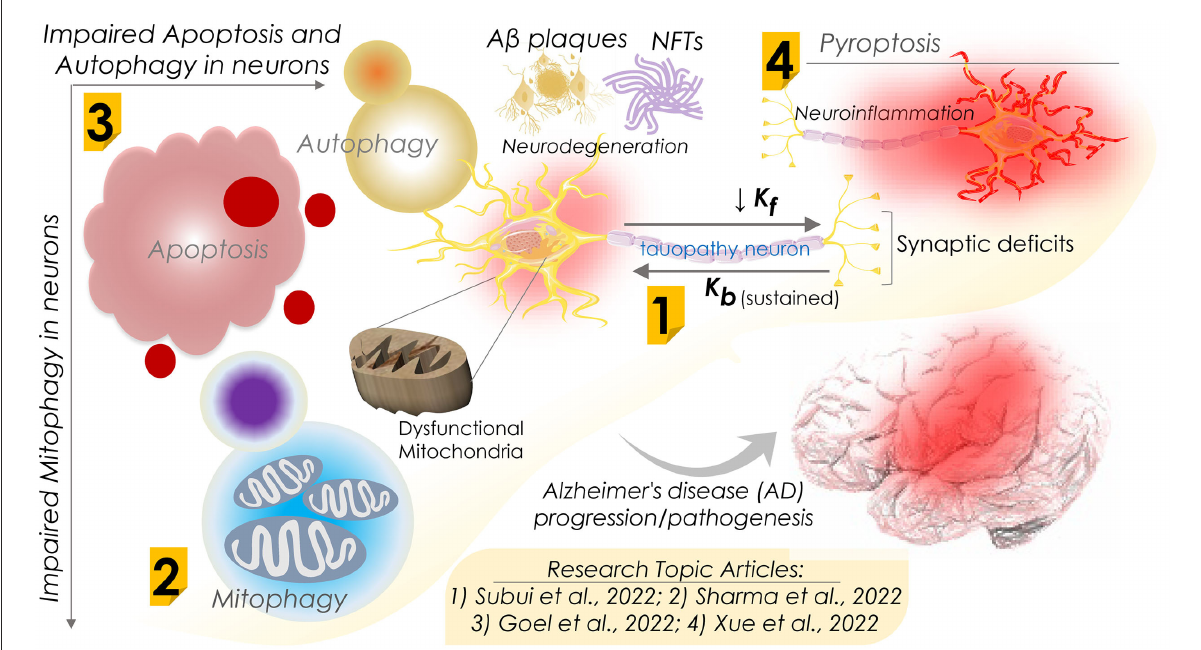
FIGURE1 Schematic diagram showing dysfunctions of apoptosis, autophagy, mitophagy, and pyroptosis in Alzheimer’s disease progression and their mechanisms. Research Topic articles are denoted by serial number within the related schematic section; k f and k b represent kinesin and dynein mediated flux,